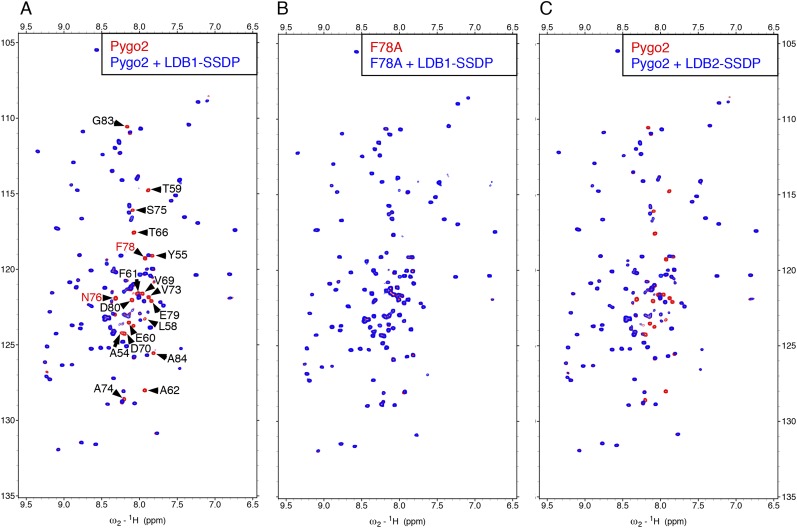
Direct NPF-dependent binding of Pygo2 by ChiLS.Overlays of BEST-TROSY spectra of 50 μM 15N-labeled (A, C) wt or (B) F78A mutant human Pygo237-93 alone (red) or probed with 100 μM (A, B) MBP-LDB156-285- Lipoyl-SSDP1-92 (blue) or (C) MBP-LDB220-246- Lipoyl-SSDP1-92 (blue); interacting residues are labeled, with NPF motif in red (binding to P is not detectable by BEST-TROSY).